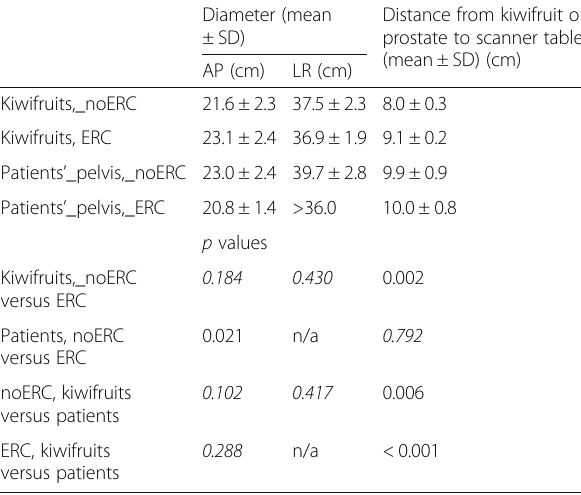
Table 6 Diameters of kiwifruit phantom and human pelvis, and respective distances from the posterior surface of kiwifruit and human prostates to the scanner table Diameter (mean Distance from kiwifruit or ± SD) prostate to scanner table (mean ± SD) (cm) AP